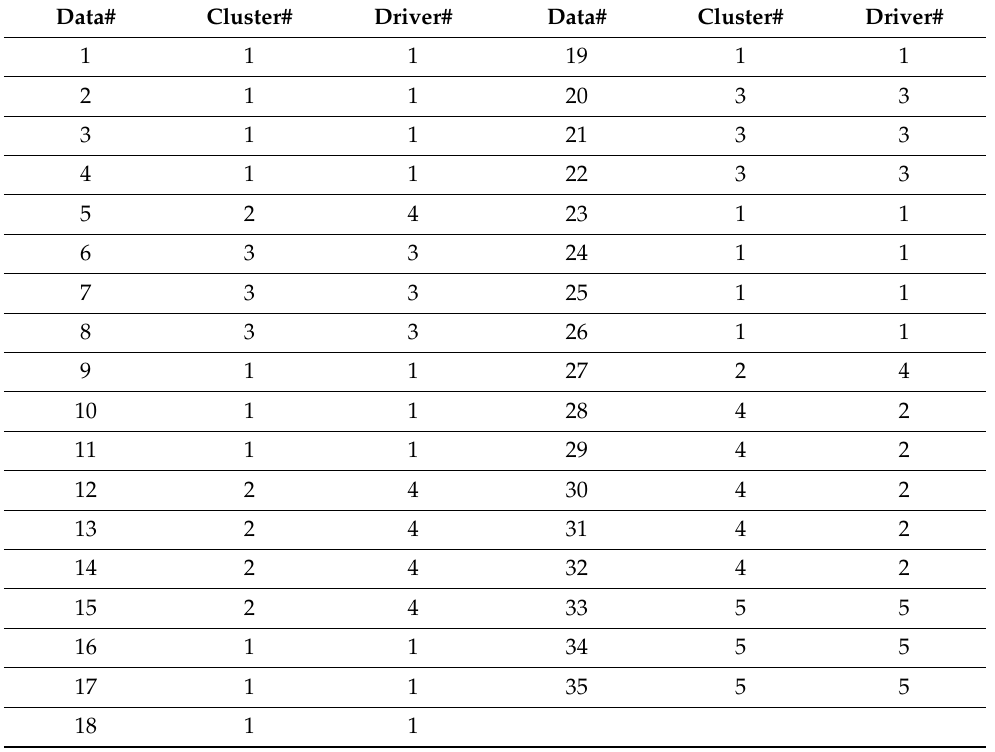
Table 6. Log of data sequence, cluster assignment, and driver identification number with probability threshold set at 0.95.